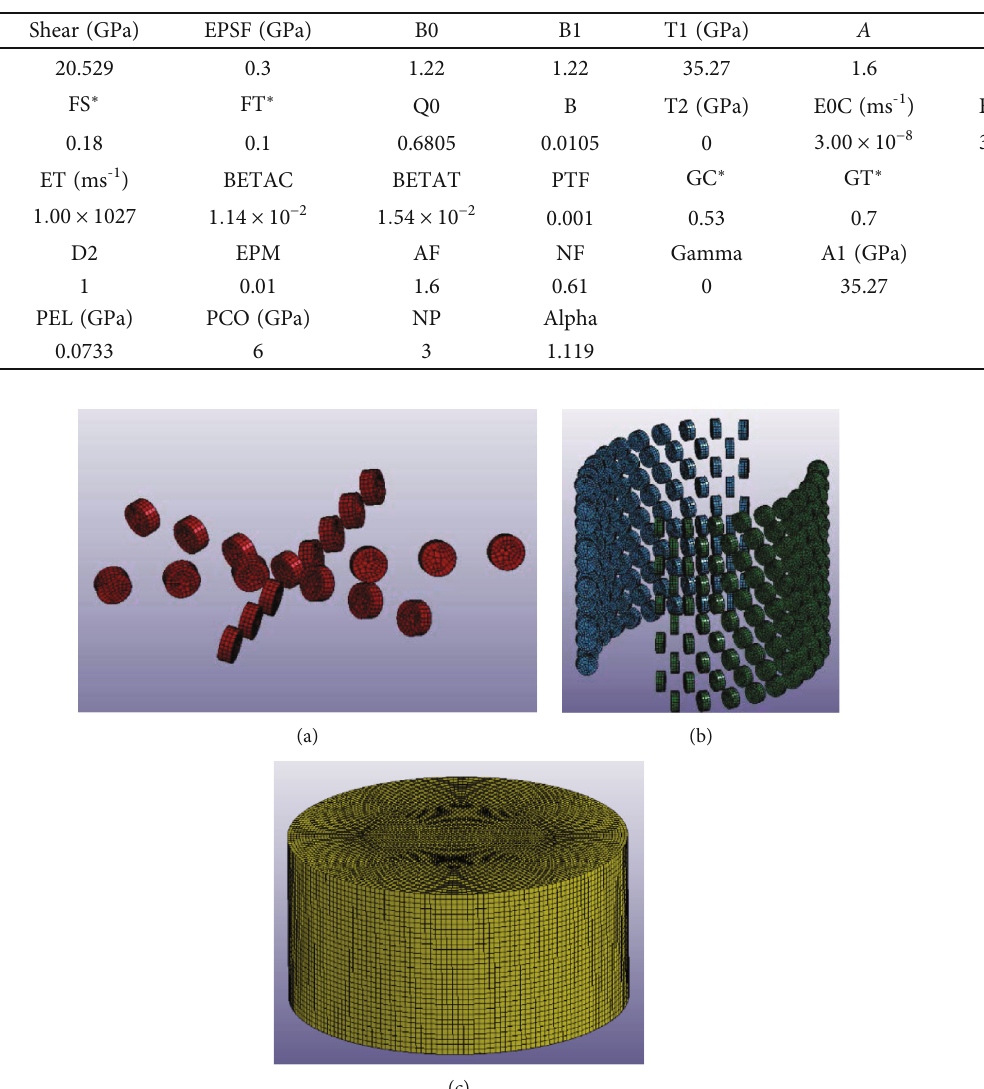
Table 3: Material parameters of limestone RHT model.